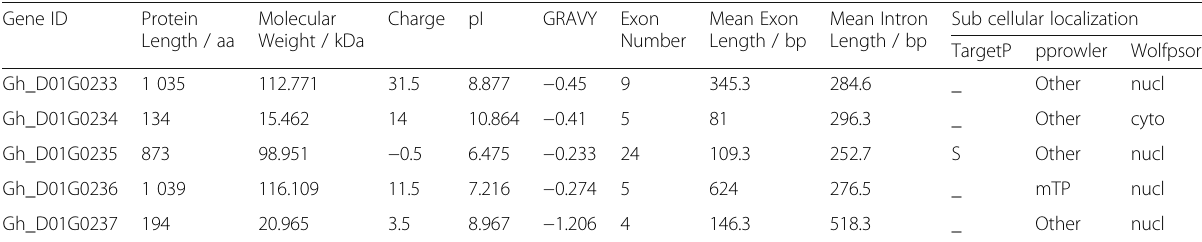
Table 4 Physiochemical properties and sub cellular localization prediction of the mined genes within the major clusters of the consistent QTLs (Continued) Protein Molecular Charge Length / aa Weight / kDa